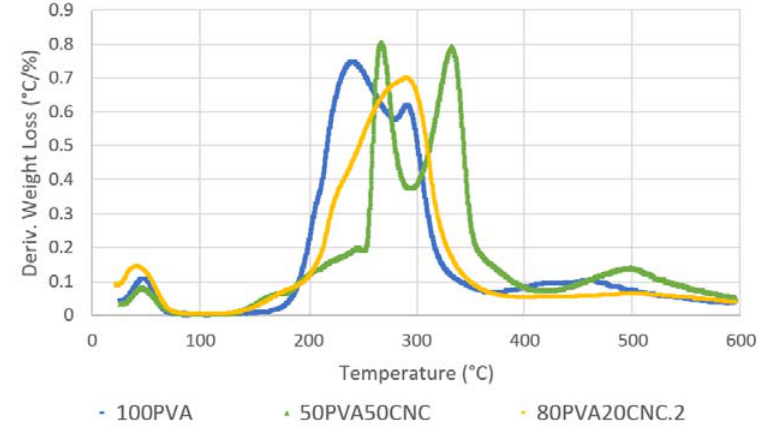
Figure 7. TGA curves showing derivative weight loss (%/°C) 100 PVA , 80 PVA 20 CNC and 50 PVA 50 CNC electrospun random composite mats.